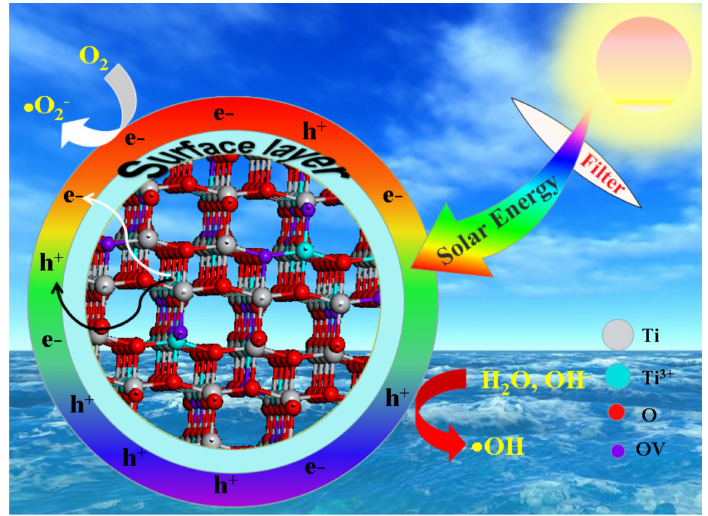
Figure 8. Schematic illustration of the visible-light photocatalytic mechanism of the Ti 3+ self-doped TiO 2